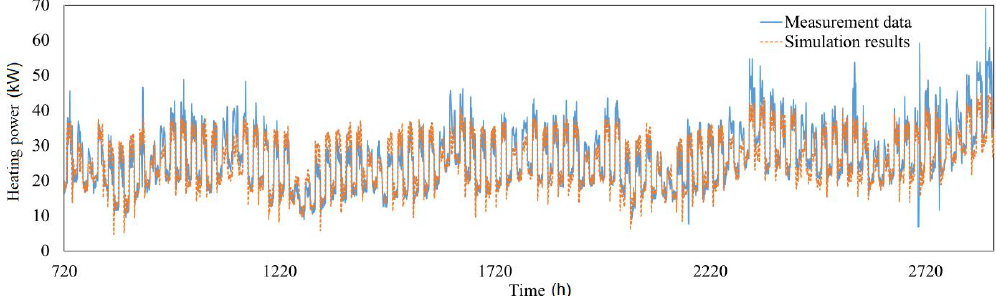
Figure 6. An example of a 3-month comparison between measured and simulated heat consumption in the model validation.